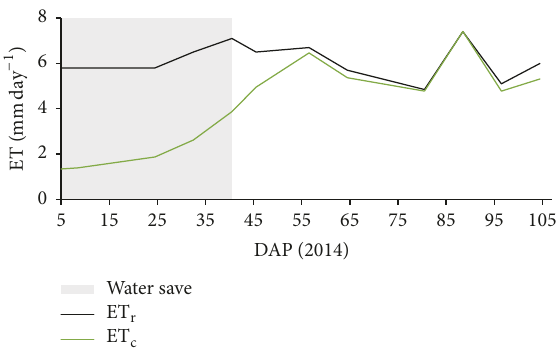
Figure 11: Comparison between ET season in northern Mexico. The grey wide column indicates the time interval where producers can save irrigation